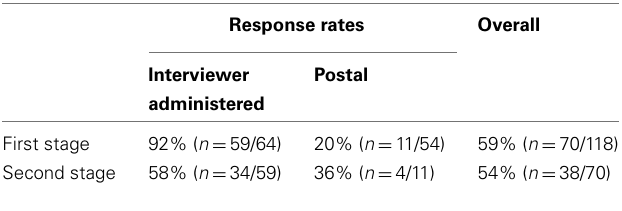
Table 3 | Clinical characteristics of the study